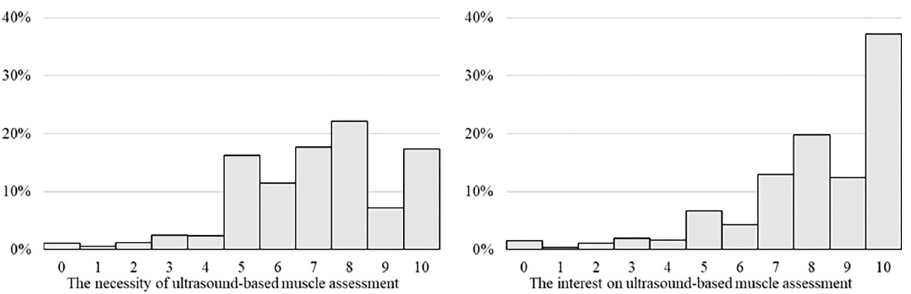
Fig 3. The necessity of and interest in ultrasound-based muscle mass assessment. The necessity of and interest in ultrasound-based muscle mass assessment were assessed using an 11-point Likert scale ranging from 0 to 10. The necessity of and interest in ultrasound-based muscle mass assessment were 7 (6–8) and 8 (7–10),